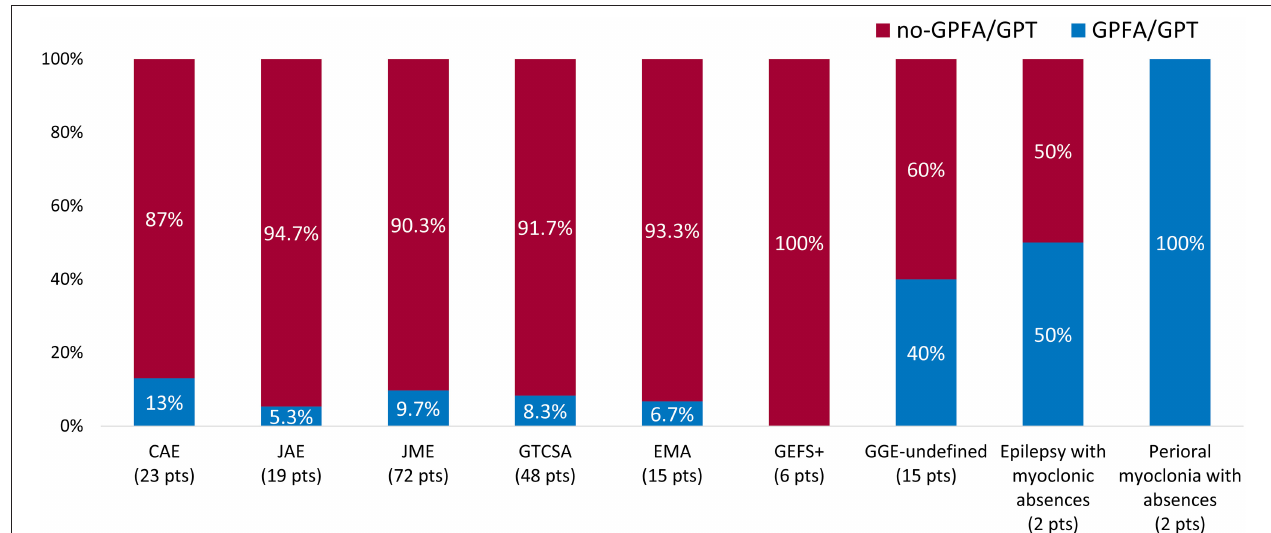
FIGURE 2 | Generalized fast discharge distribution according to epilepsy syndrome. Proportion of patients showing EEG generalized fast discharges according to genetic generalized epilepsy (GGE) syndrome. The percentage of patients showing generalized fast discharges in each syndrome is reported in the blue bars. The absolute number of patients diagnosed with each syndrome is reported in brackets. GPFA, generalized paroxysmal fast activity; GPT, generalized polyspike